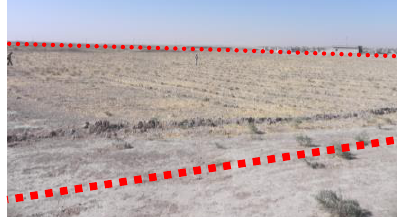
Figure 3 - A large square enclosure located in the northern part of the site as seen on site Inside and in surroundings of the enclosure could be collected